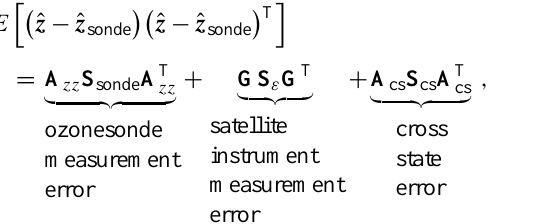
Figure 3 . Ozone volume mixing ratios measured by the instruments on Aura satellite and ozonesonde over Naha, Okinawa, Japan on August 1 st , 2007. It is the same scenario as the one shown in Figure 1. (A) Joint TES and OMI vs. Ozonesonde; (B) TES only vs. Ozonesonde; (C) OMI only vs. Ozonesonde; (D) Percentage differences between joint retrieval and co-located sonde measurements; (E) Percentage differences between TES retrieval and co-located sonde measurements (F) Percentage differences between OMI retrieval and co-located sonde measurements. In Panels A, B and C, retrieved profiles in green; ozonesonde measurements are in black; ozonesonde profiles smoothed by averaging kernels of TES or OMI in blue; A priori in magenta.